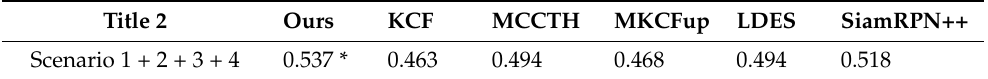
Table 4. Tracking accuracy using Metrics-2.